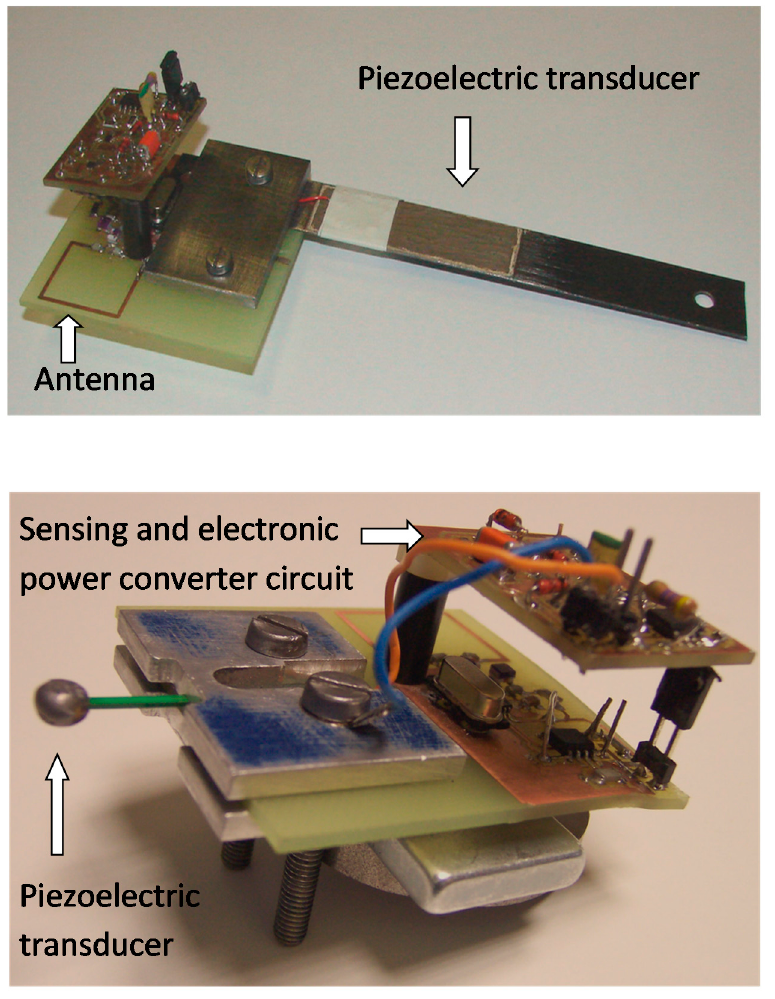
Figure 12. The realized prototype of the autonomous sensor module with a thick-film piezoelectric converter ( top ) and with a commercial piezoelectric converter ( bottom ) (adapted from [141] with authors permission).